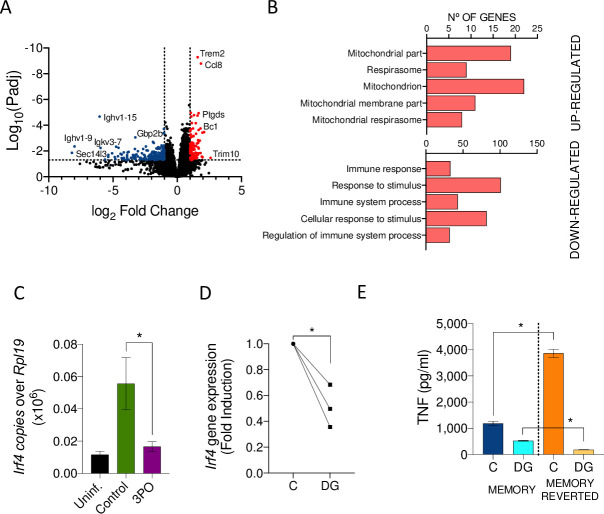
Inhibition of glycolysis reverts the Irf4-induced memory phenotype in murine macrophages and during Lyme borreliosis.(A) Volcano plot representing genes differentially expressed in the hearts of mice infected and treated with 3-PO compared to infected controls. The red dots represent genes up-regulated (110), while the blue dots correspond to down-regulated genes (232) in 3-PO treated animals determined by the absolute value of log2 fold induction (= 1) and Padj < 0.05. (B) Bar graphs showing the number of genes up- (top) and down-regulated (bottom) in infected animals treated with 3-PO compared to infected controls. The legend indicates GO-BP. (C) Irf4 gene expression in the hearts of mice infected and treated with 3-PO starting day 14 of infection (purple bar), compared to control-treated infected mice (green bar) and uninfected controls (black bar). Gene expression levels were determined by real-time PCR relative to Rpl19. Groups of 5 mice were analyzed. *, Student t test, p < 0.05. (D) Irf4 expression by memory macrophages treated with 2-DG during restimulation (20 hours) with B. burgdorferi compared to untreated controls. Results were obtained from 3 independent mice. *, Student t test, p < 0.05. (E) TNF production by control-treated memory macrophages (MEMORY) and memory macrophages pretreated with 2-DG for 20 hours (MEMORY REVERTED). Both memory and memory reverted macrophages were stimulated with B. burgdorferi for 20 hours in the absence (C) or presence of 2-DG. The results represent the average ± SE of 4 independent mice. The data underlying the graphs in Fig 7 can be found in S7 Data and GSE152168. 2-DG, 2-deoxyglucose; 3-PO, 3-(3-pyridinyl)-1-(4-pyridinyl)-2-propen-1-one; GO-BP, Gene Ontology Biological Process; PCR, polymerase chain reaction; SE, standard error; TNF, tumor necrosis factor.